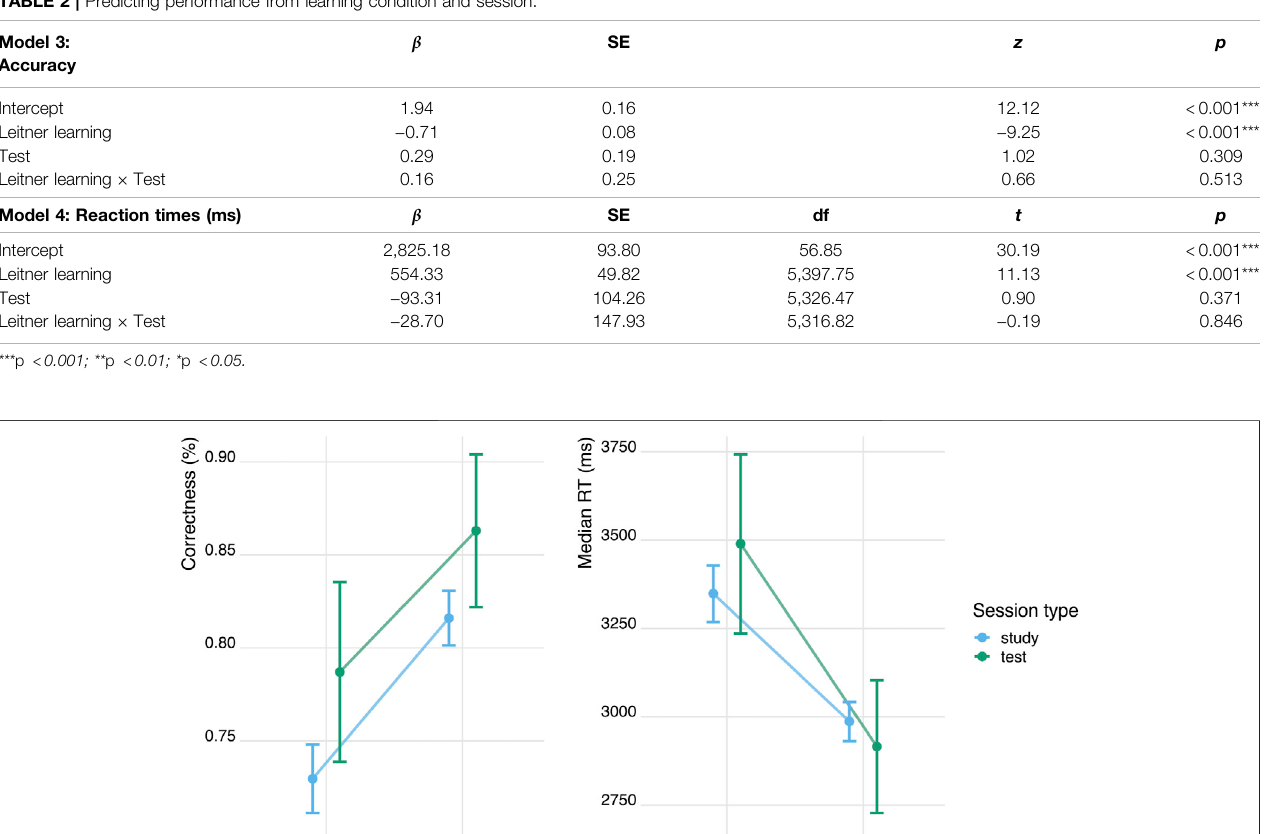
TABLE 2 | Predicting performance from learning condition and session.